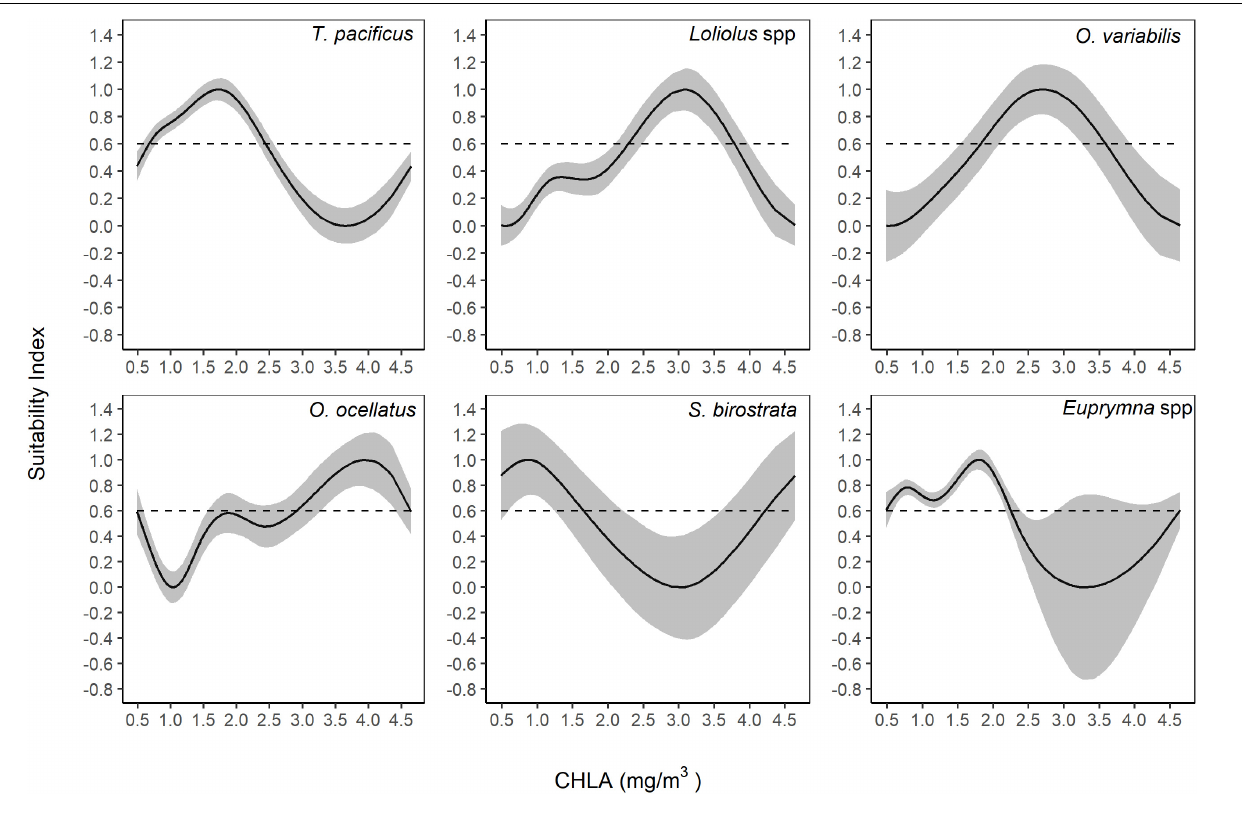
FIGURE 8 | Suitability index for chlorophyll-a concentration (CHLA) based on the smoothing spline regression method. TABLE 3 | Summary of linear regression analyses between the predicted and estimated habitat suitability index (HSI) values for the arithmetic mean method (AMM) and the geometric mean method (GMM) from 100 cross-validation runs. Species Intercept ( α ) Slope ( β